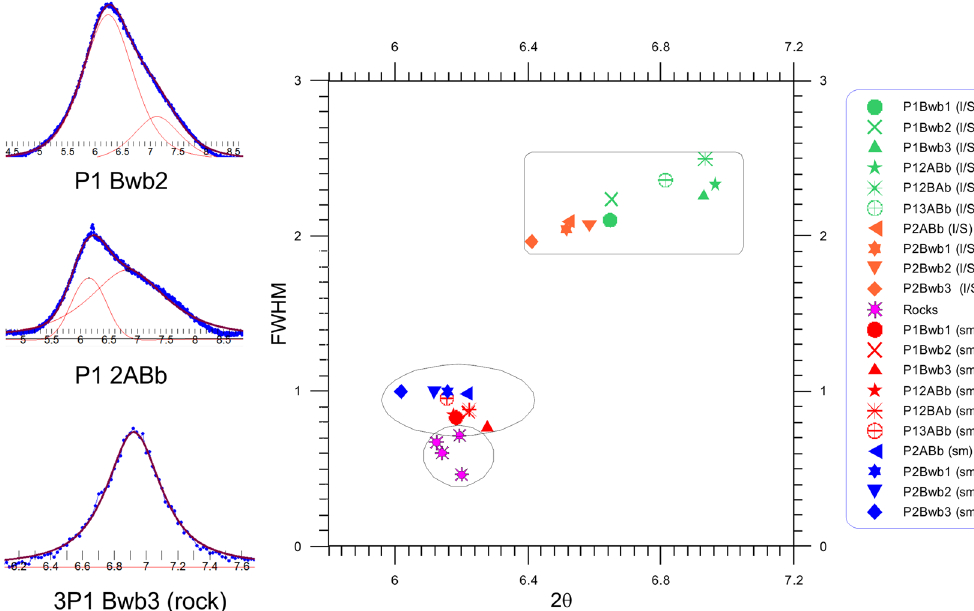
Figure 6. Degree of crystallinity of smectitic and interstratified components of the paleosol samples and the parent material. ( a ) Examples of profile fitting analysis obtained for clay samples of selected horizons; ( b ) Full width at half maximum (FWHM) of paleosols and rock samples. The lower the FWHM, the better the crystallinity and vice-versa. Smectitic component of P1 and P2 in red and blue, respectively. Interstratified component of P1 and P2 in green and orange, respectively. Smectite of rocks samples in pink. Each symbol represents one horizon. Note the smectitic component is more crystalline than the I/S component. Smectite from the rocks has a higher crystallinity with lower FWHM